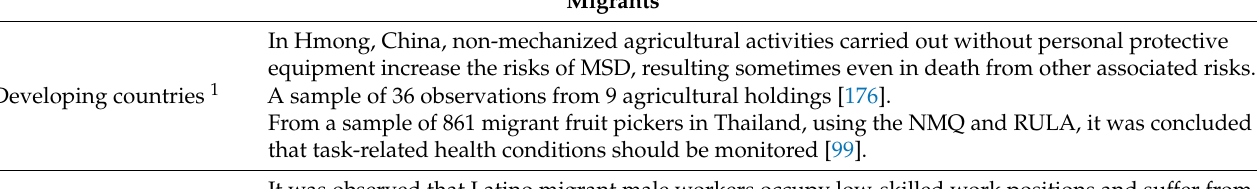
Developing countries